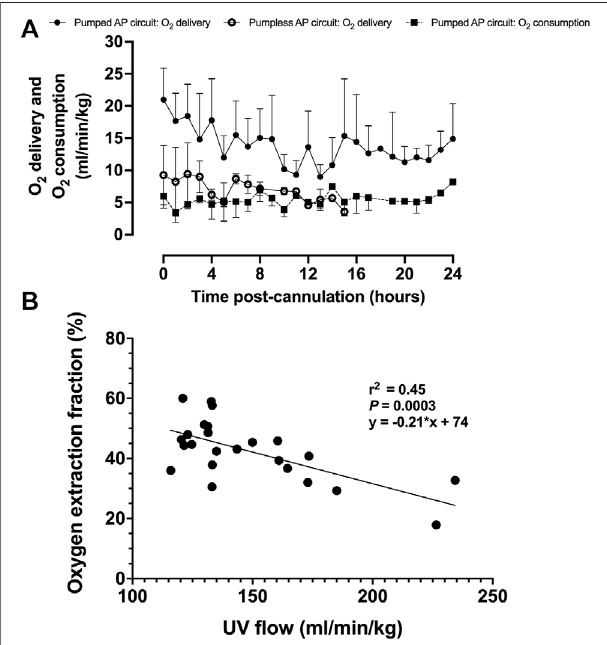
FIGURE 7 | Fetal oxygen delivery, oxygen consumption, and oxygen extraction fraction on a pumped AP circuit. (A) Fetal oxygen delivery on the pumped AP circuit is represented as black circles ( n = 13) and open circles for the pumpless AP circuit ( n = 5) (Charest-Pekeski et al., 2021), whereas oxygen consumption is shown as black squares with a dashed line ( n = 11). (B) Correlation between UV fl ow and oxygen extraction fraction ( n = 11). Data are presented as 1-h averages over the fi rst 24 h of AP